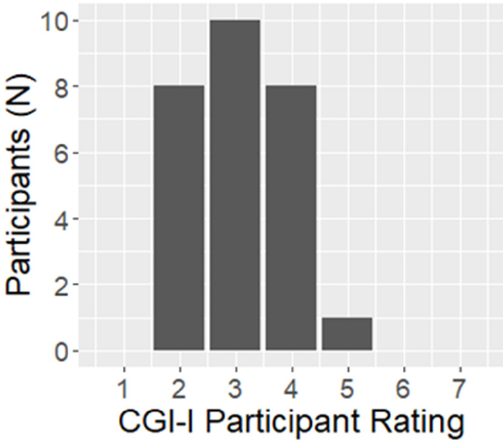
Figure 3. Final Participant Clinical Global Impression–Improvement Scores (n = 27). 1 = Very much improved—nearly all better; good level of functioning; minimal symptoms; represents a very substantial change. 2 = Much improved—notably better with significant reduction of symptoms; increase in the level of functioning but some symptoms remain. 3 = Minimally improved—slightly better with little or no clinically meaningful reduction of symptoms; represents very little change in basic clinical status, level of care, or functional capacity. 4 = No change—symptoms remain essentially unchanged. 5 = Minimally worse—slightly worse but may not be clinically meaningful; may represent very little change in basic clinical status, level of care, or functional capacity. 6 = Much worse—clinically significant increase in symptoms and diminished functioning. 7 = Very much worse—severe exacerbation of symptoms and loss of functioning.